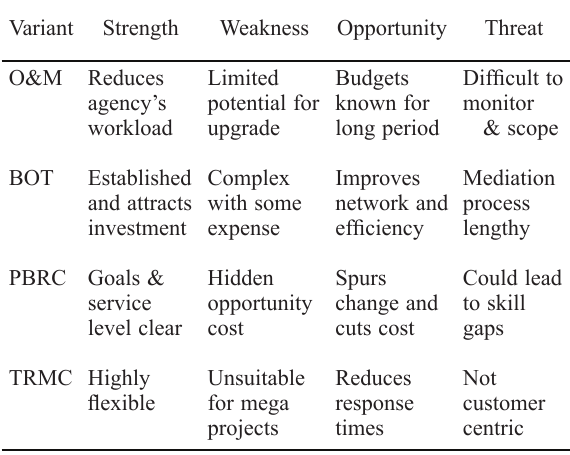
Table 2. SWOT analysis of road maintenance outsourcing